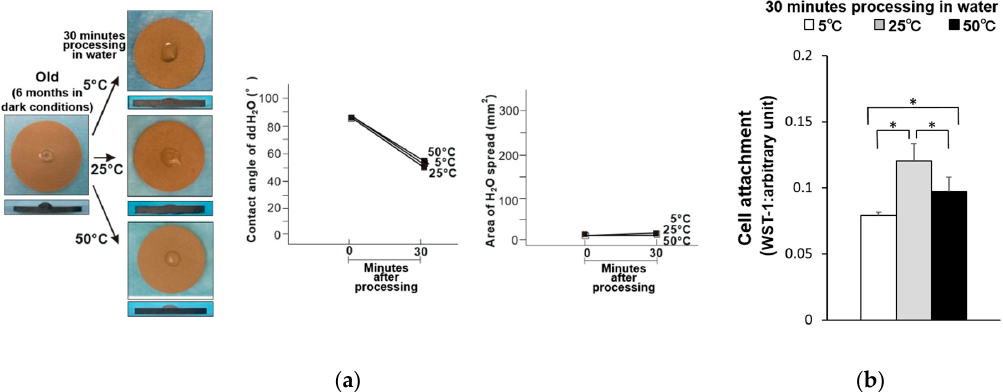
Figure 2. ( a ) Hydrophobicity/hydrophilicity of the old–wet titanium disk surfaces illustrated as a photograph of 10 µL ddH 2 O placed on the sample surface before and after temperature deviation (left) with the corresponding contact angle (middle) and spread area (right). ( b ) Initial attachment of osteoblasts to the old–wet titanium disk surfaces. * p < 0.05, statistically significant difference.